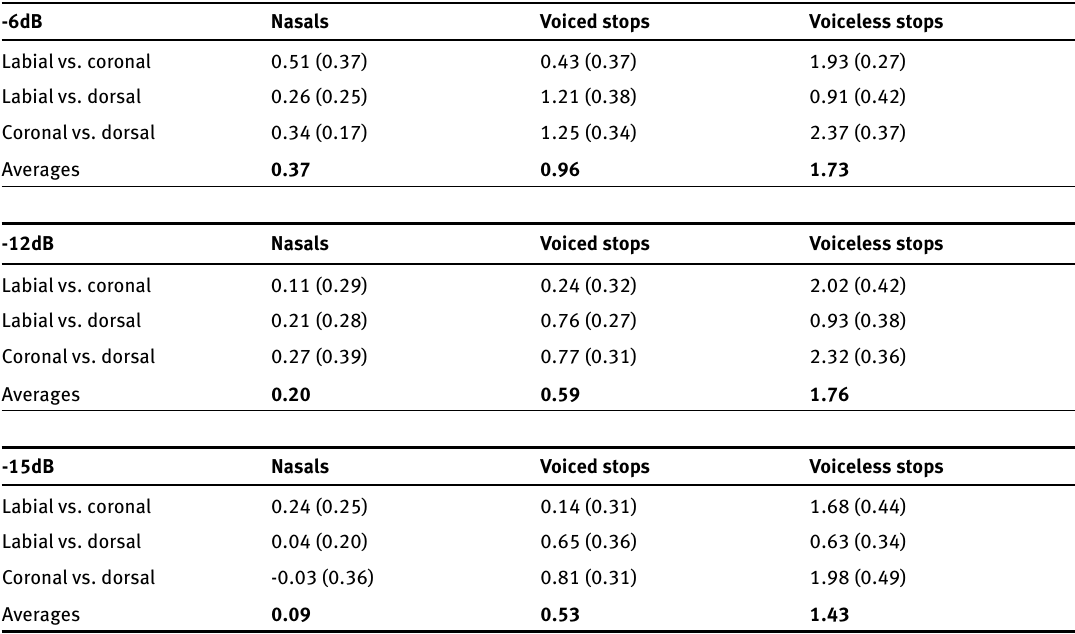
Table 3: The average d ′-values in Experiment III (margins of errors for 95% confidence